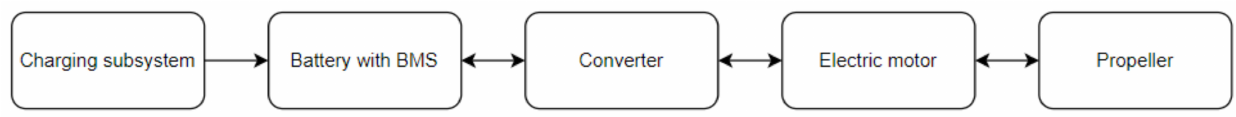
Figure 1. A general diagram of the battery-electric